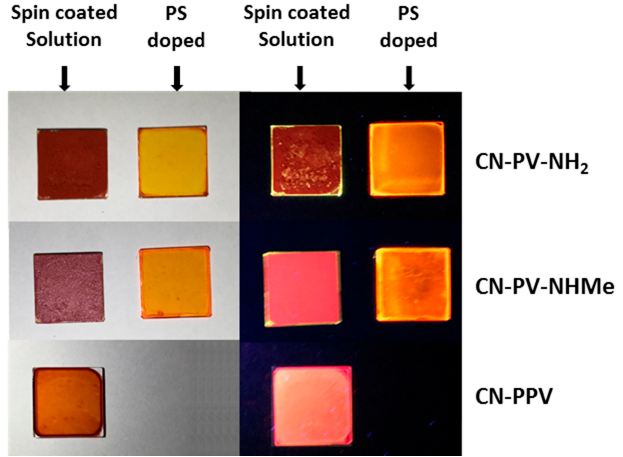
Figure 3. Fluorophore thin films ( left ) and in 10% PS-doped thin film ( right ) in natural ( left column ) and under 375 nm UV light ( right column ).